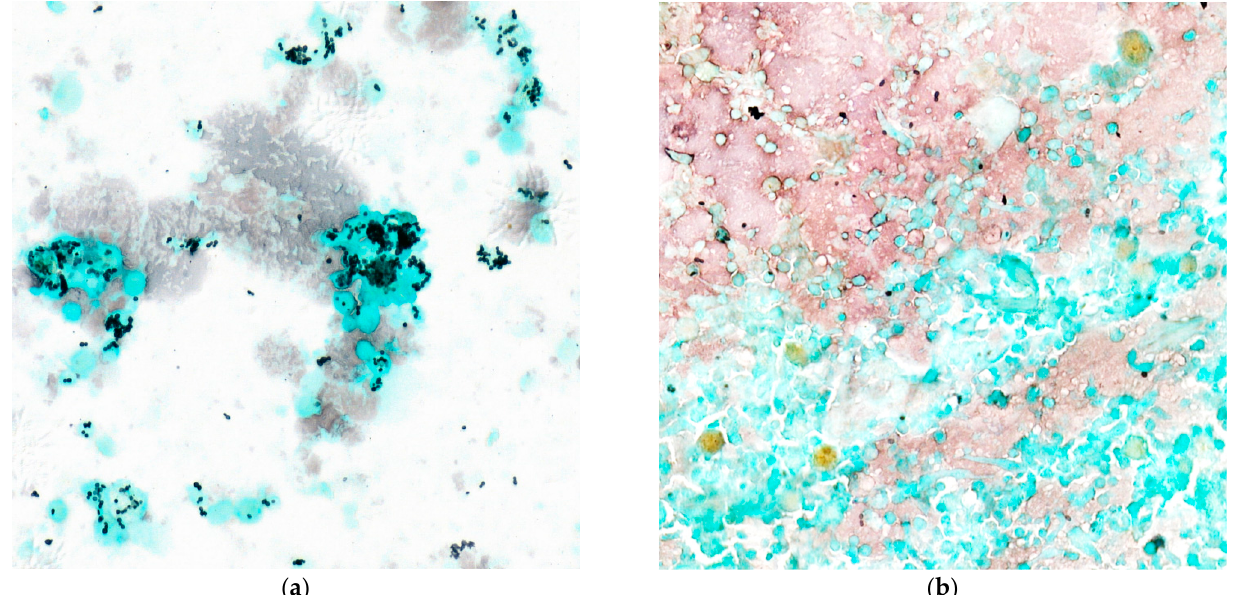
Figure 2. The number of Histoplasma capsulatum by hot spots with the Gomori-Grocott stain (light microscopy at × 40). ( a ) Shows numerous intracellular and extracellular yeasts by hot spots in a patient with a CD4 count of <200 cells/mm 3 . ( b ) Shows a few isolated yeasts sometimes arranged in small clusters.